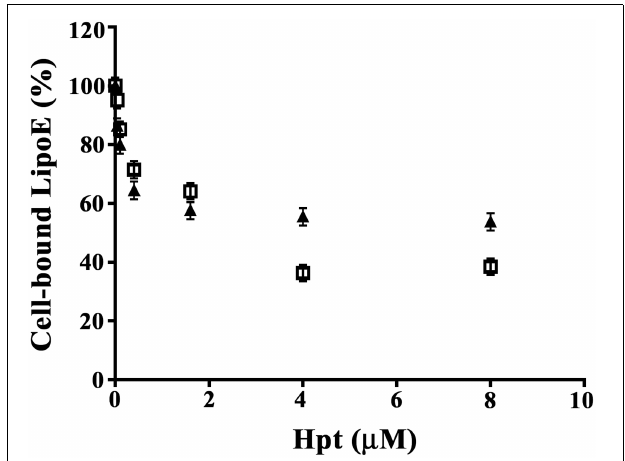
FIGURE 2 | Hpt influence on ApoE binding to cells. Differentiated SH-SY5Y (8000 cells; full triangles) or U87-MG (15,000; open squares) were fixed into the wells of a 96-well plate and then incubated with mixtures containing 0.4 μ M LipoE3 and different concentrations of Hpt (0–8 μ M). The amount of LipoE bound to cells was measured by incubation with mouse anti-ApoE IgG, followed by GAM-HRP and color development at 492nm. Data are reported as percent of the value obtained by incubation in the absence of Hpt (assumed as 100% of LipoE binding), and expressed as mean ± s.e.m.